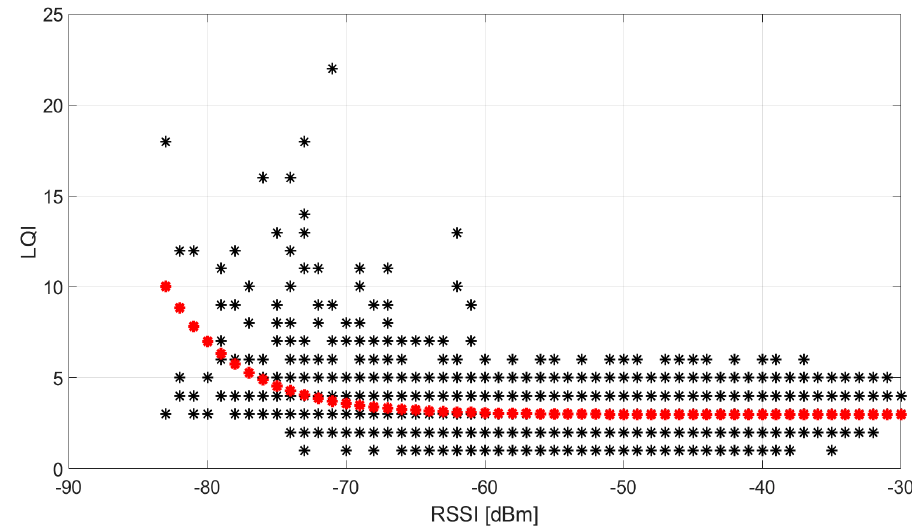
Figure 4. The exponential regression function fitted to the empirical measurement data.